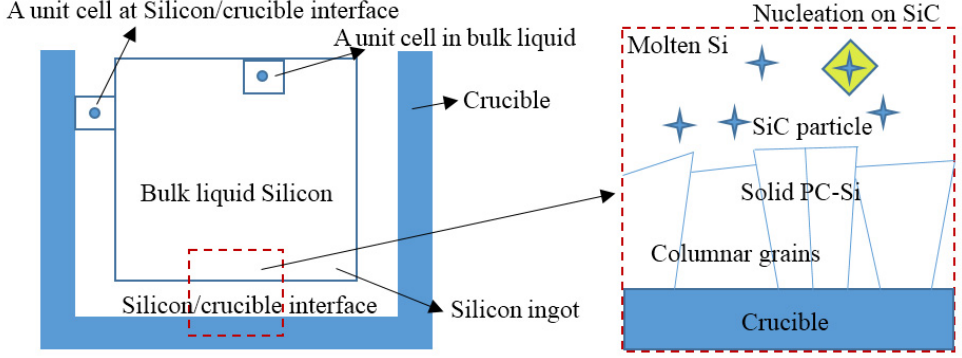
Figure 1. Nucleation at silicon-crucible interface and on SiC particles.